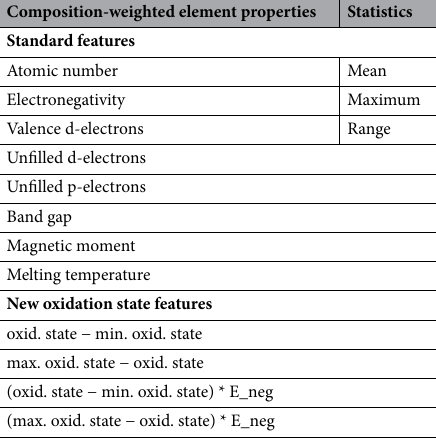
Table 2. List of 28 element property features used for predicting oxidation and reduction potentials ( vs. Li/ Li+). Each of eight standard element properties are weighted by composition and measured through three different statistics to obtain the first 24 features. The other 4 are new oxidation state features introduced in “Oxidation and reduction